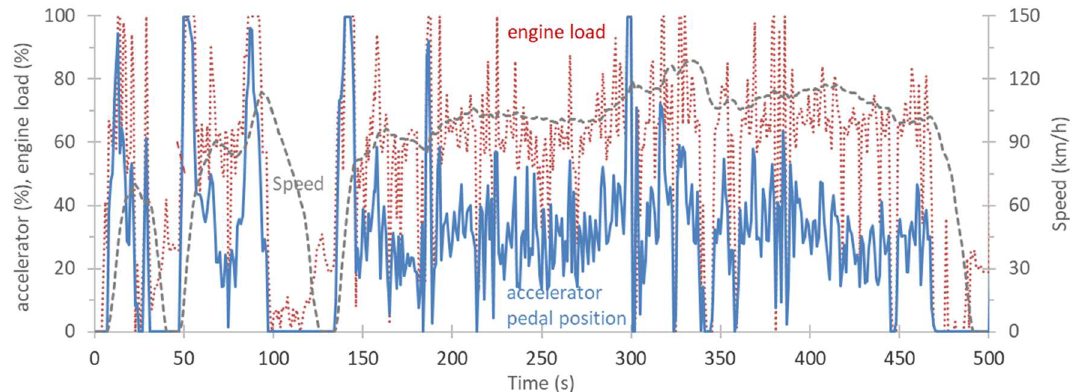
( b ) Figure A1. Emissions for various tests at different ambient temperatures applying the following corrections: CO 2 ratio, 1.6 for temperatures <0 °C, normalization to 16 km for cycles with shorter distance. All tests with 84% payload (1850 kg test mass), except those with “L” and the −4 °C tests where the test mass was lower (1550 kg). Solid symbols are cold start tests, while open symbols are hot start tests. Lighter colors indicate tests with lower payload (mass). Auxiliaries were activated only at the −9 °C tests. ( a ) Solid particle number >23 nm with the evaporation tube (SPN 23,ET ). The dotted line shows the limit for the type approval cycle WLTC. ( b ) Solid particle number >10 nm with the catalytic stripper (SPN 10,CS ).